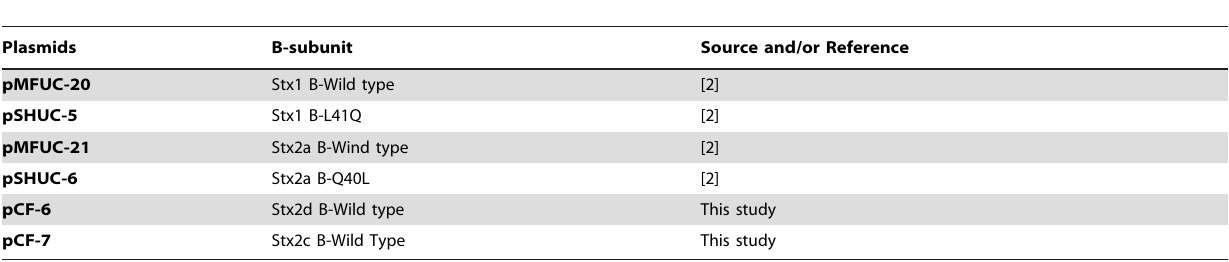
Table 3. Sources of B-subunit plasmids used in this study.